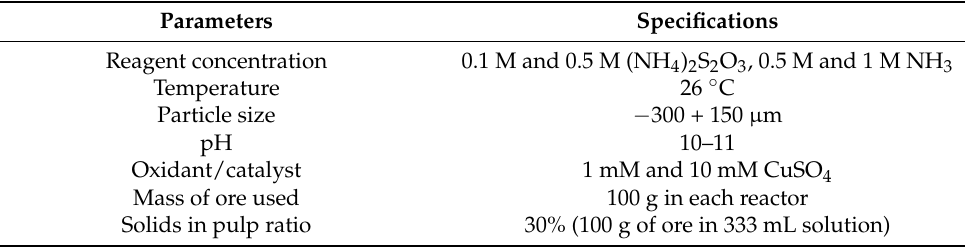
Table 3. Thiosulphate leaching experiment conditions.